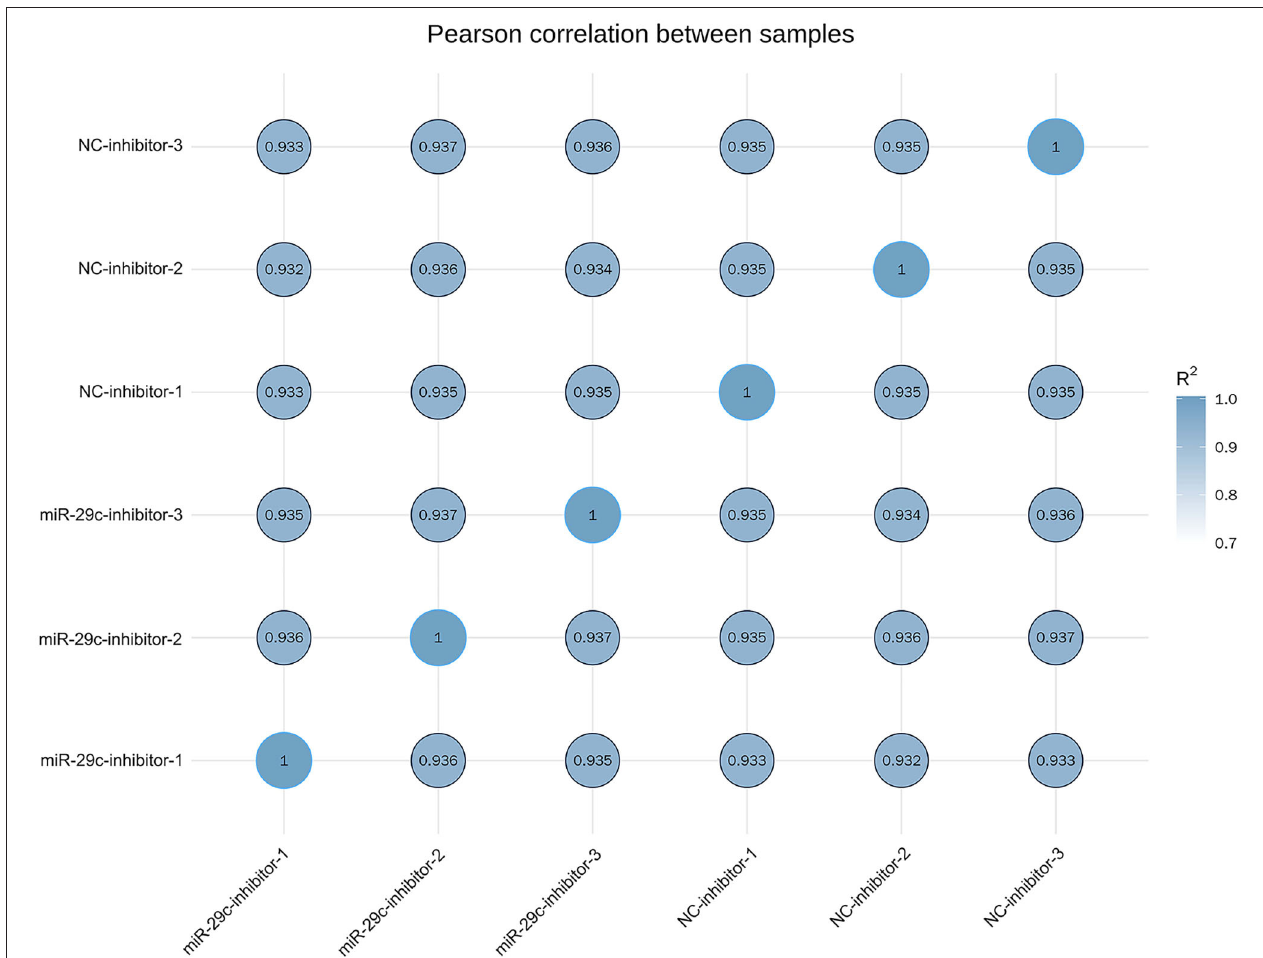
FIGURE 3 | Heat map of the correlation coefficient between samples.